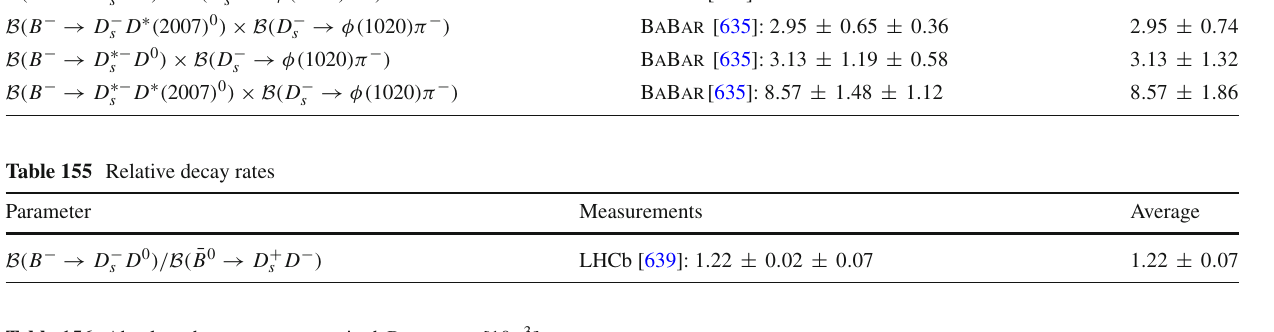
Table 156 Absolute decays rates to excited D s mesons [ 10 − 3 ] Parameter